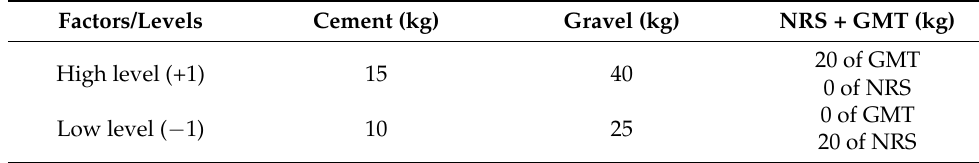
Table 1. Experimental domain of the DOE.